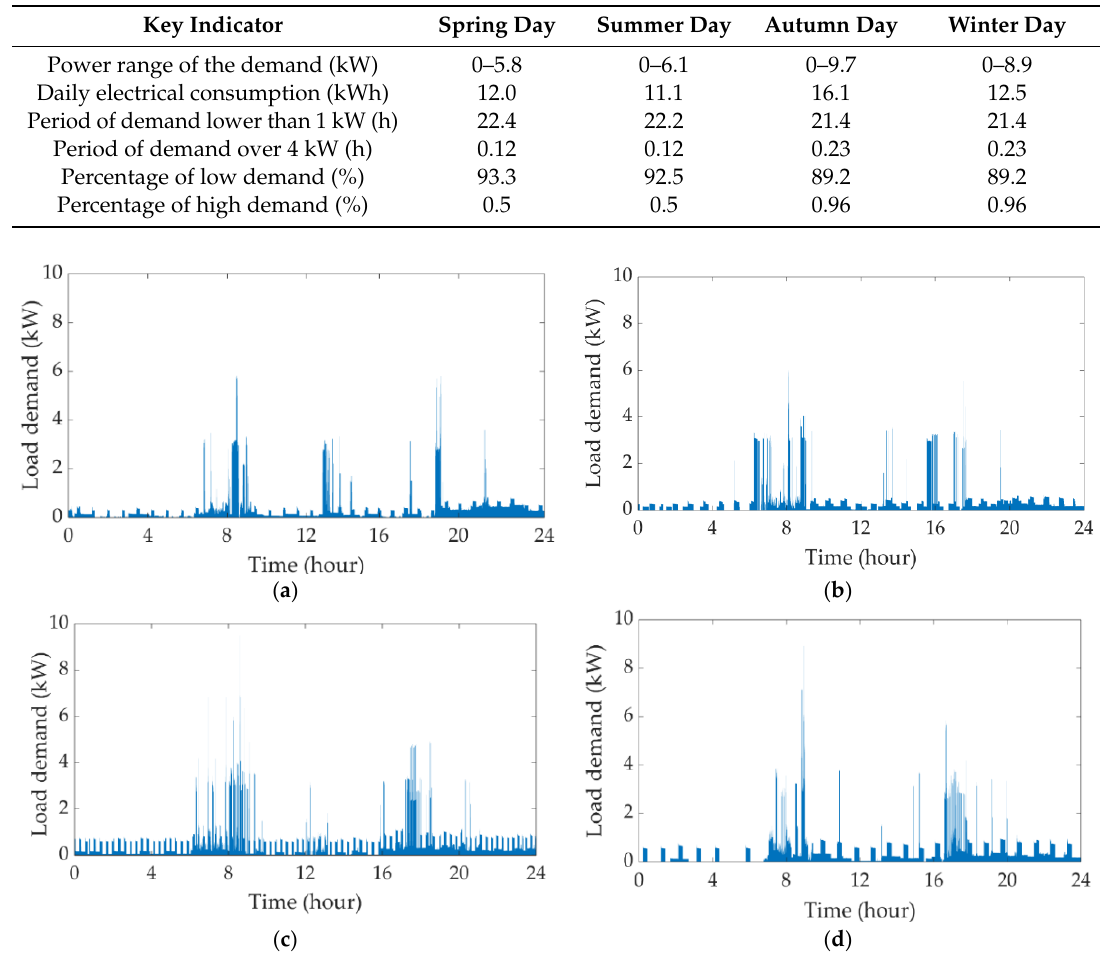
Figure 8. Typical days for domestic electricity consumption over the four seasonal days in a UK house [31]. ( a ) spring day; ( b ) summer day; ( c ) autumn day; ( d ) winter day.